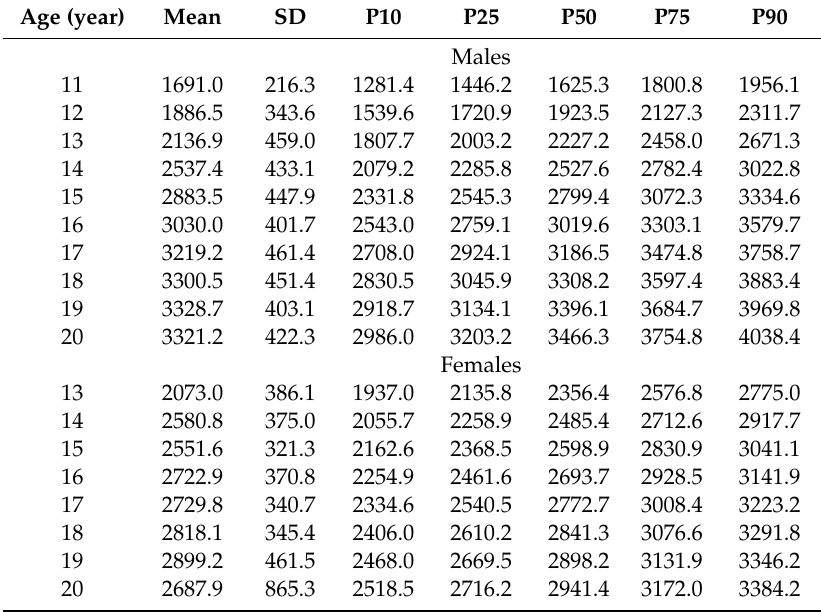
Table A3. Basic statistical parameters (mean, SD, and 10th, 25th, 50th, 75th, and 90th percentiles) for BMC (g) in youth male and female